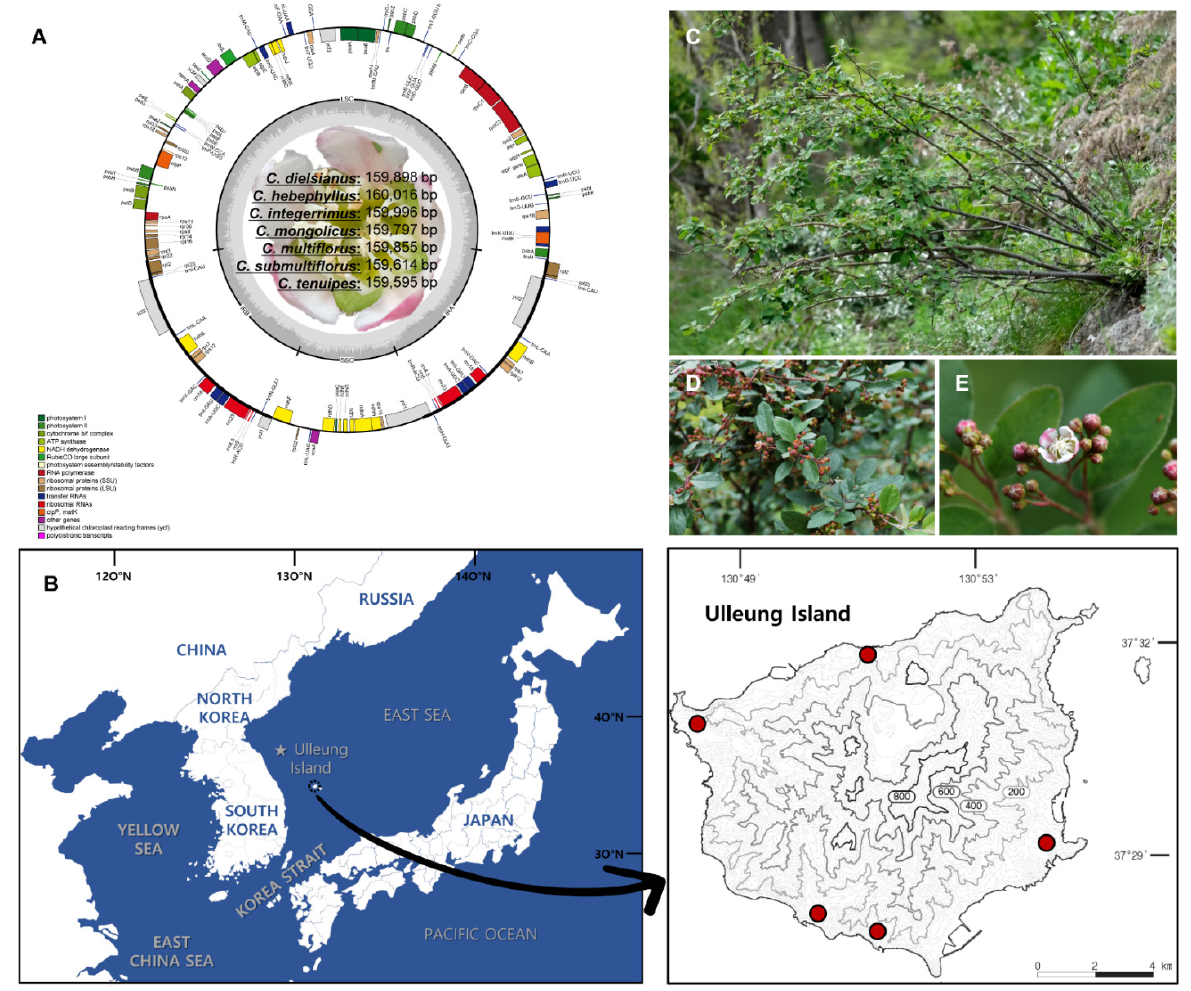
Figure 1. The complete plastome map of the seven newly sequenced Cotoneaster species in this study and Cotoneaster wilsonii on Ulleung Island ( A ) The genes located outside the circle are transcribed clockwise, whereas those located inside are transcribed counterclockwise. The gray bar area in the inner circle denotes the guanine-cytosine (GC) content of the genome, whereas the lighter gray area indicates the adenosine-thymine (AT) content of the genome. Large single copy, small single copy, and inverted repeats are indicated as LSC, SSC, and IR, respectively. Ψ indicates pseudogenes. ( B ) The contour map of Ulleung Island shows the population locations of critically endangered C. wilsonii . One typical habitat ( C ) of C. wilsonii on the eastern part of the island, with the inflorescence ( D ), and flowers ( E ) is shown.